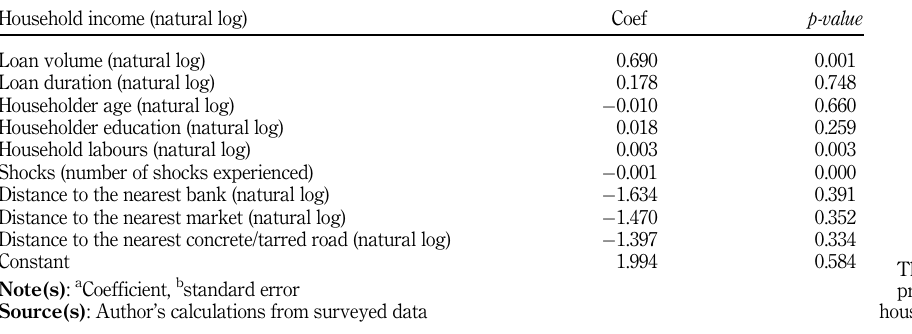
Table 3. The impact of